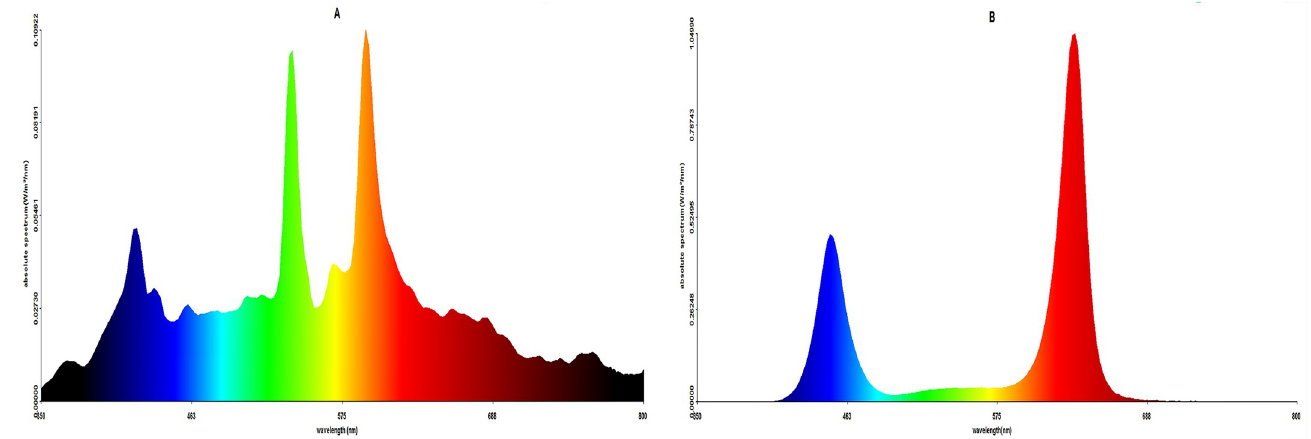
Fig 1. Spectra of two types of lamps. (A, HPS; B,